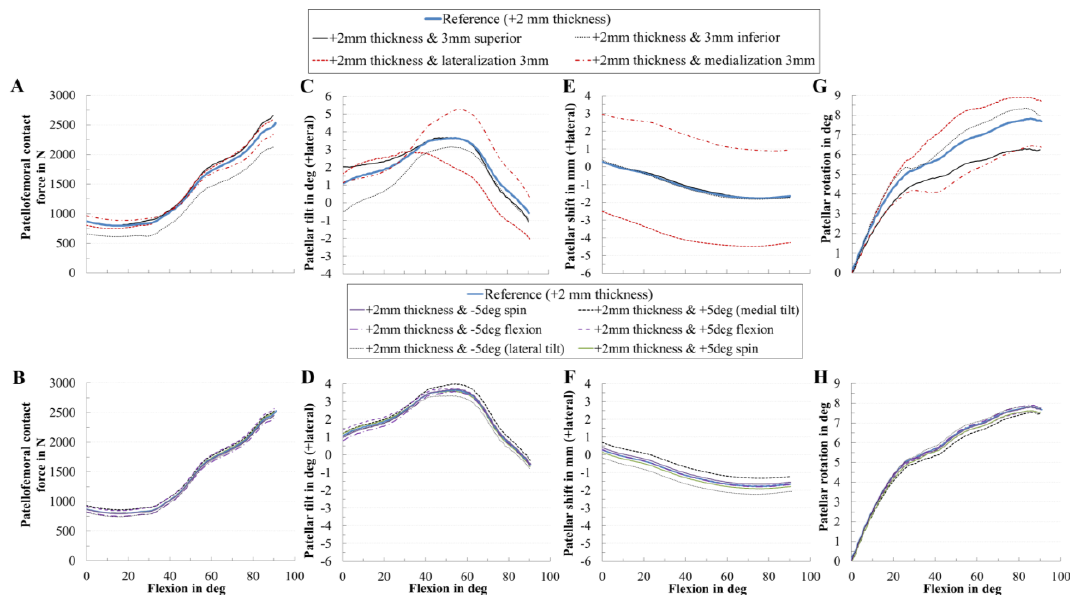
Figure 11. Effect of the increase of the patellar component thickness by +2 mm with all positioning parameters on patellofemoral dynamics. Effect of patellar component thickness combined with the positioning parameters on patellofemoral contact force ( A , B ), patellar tilt ( C , D ), patellar shift ( E , F ), and patellar rotation ( G , H ).